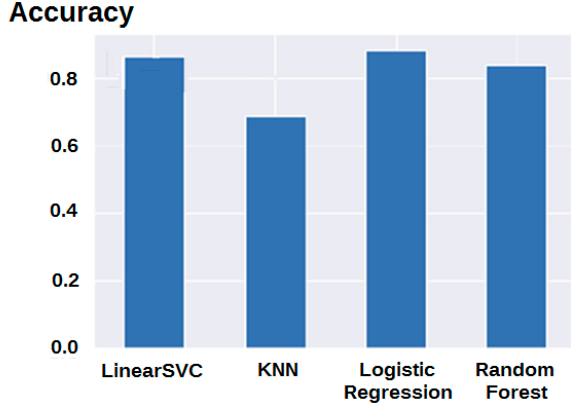
Figure 9. Models comparison: Logistic regression model exhibited the highest accuracy. The logistic regression model was very good achieving an AUC = 0.92 (a perfect model would achieve an AUC = 1.0) (Figure 10).